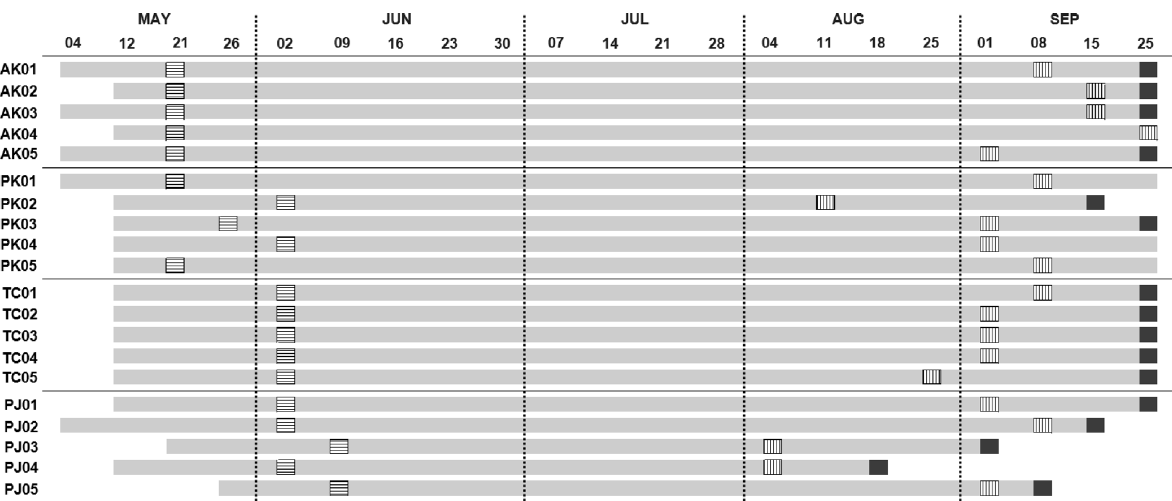
Fig. 5 Durations of cambial activity (grey bars) in Abies koreana (AK), Pinus koraiensis (PK), Taxus cuspidata (TC) and Picea jezoensis (PJ). The boxes with horizontal and vertical lines indicate when the cell‑wall thickening begun the first time and the cell division ended in the cambial zone, respectively, while the black boxes indicate when cell‑wall thickening ended